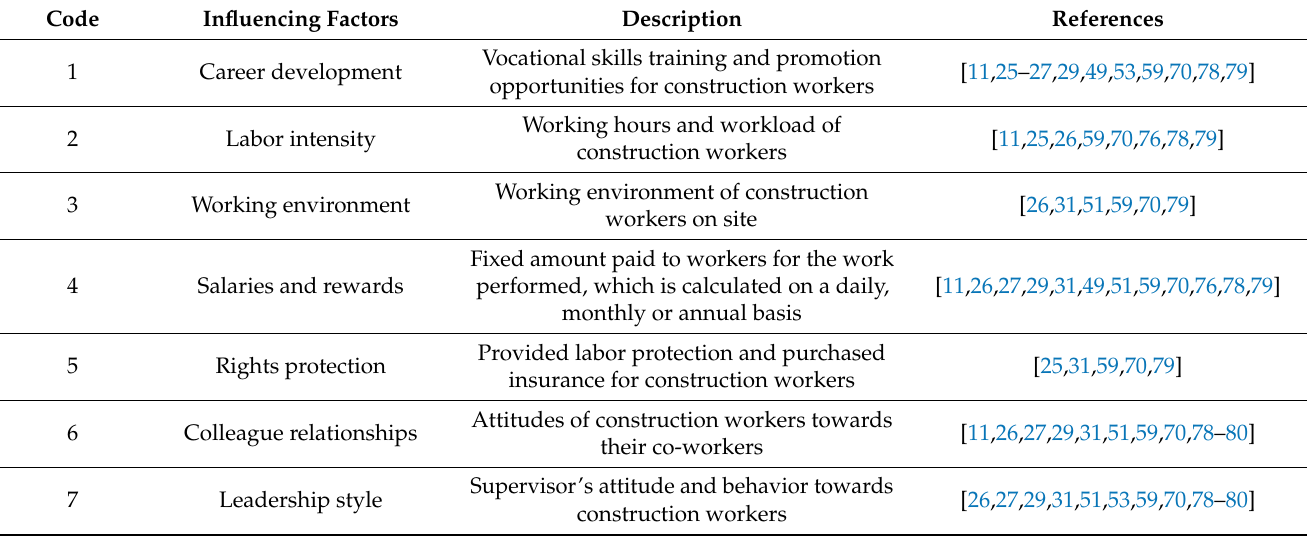
Table 1. Factors of job characteristics that affect job satisfaction of